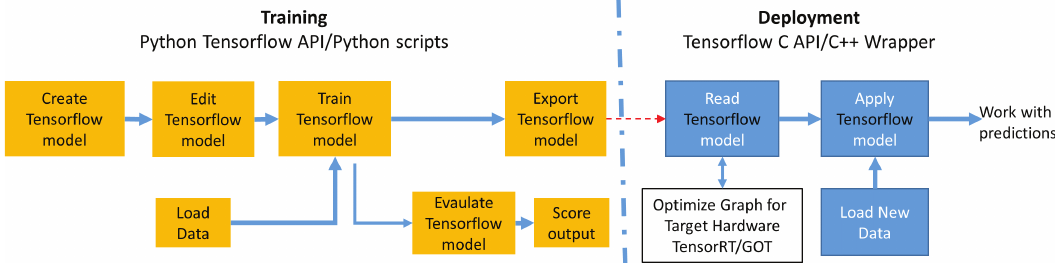
Figure 7. A graph was built and trained in Python, then frozen and run in C++ for